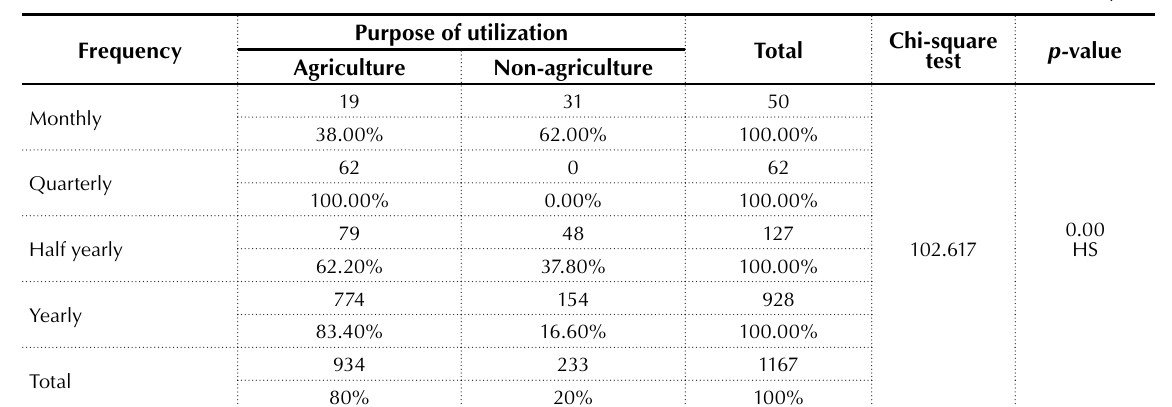
Table 16. Impact of credit frequency on the purpose of agricultural credit utilization